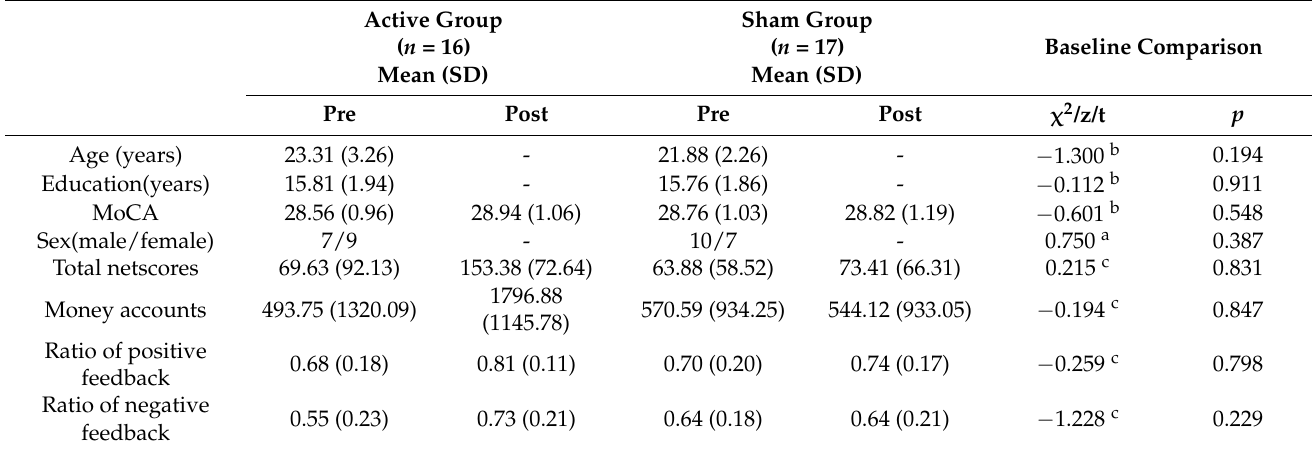
Table 1. Demographic characteristics and IGT performance of